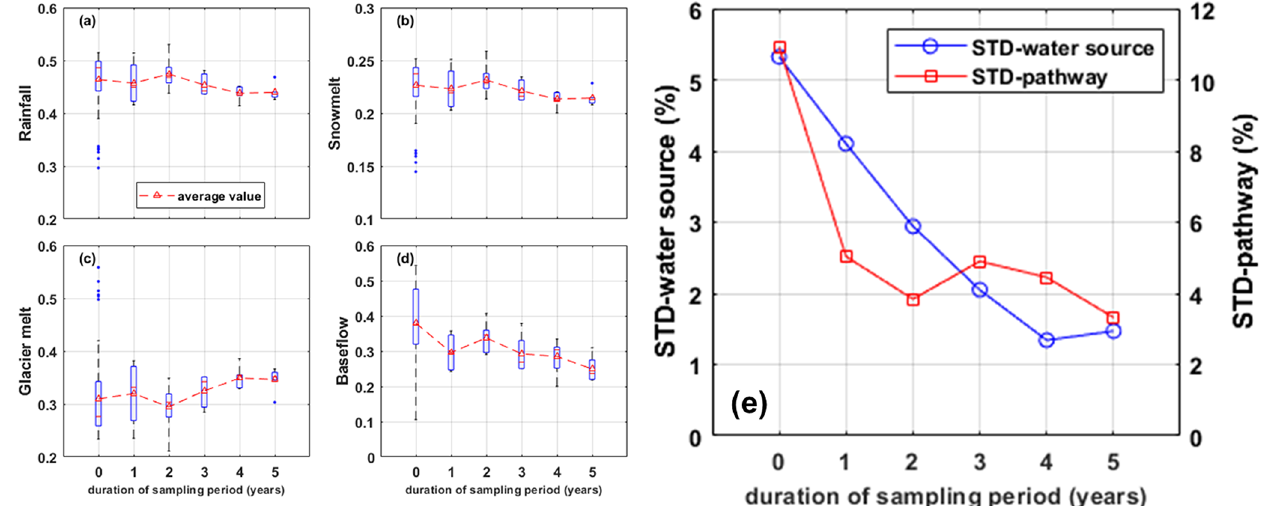
Figure 11. Uncertainties of the contributions of (a) rainfall, (b) snowmelt, (c) glacier melt, and (d) baseflow in the KR catchment, estimated by scenarios with different durations of sampling period (Experiment 3). The uncertainties of CRCs based on two different definitions are summarized in subplot (e)